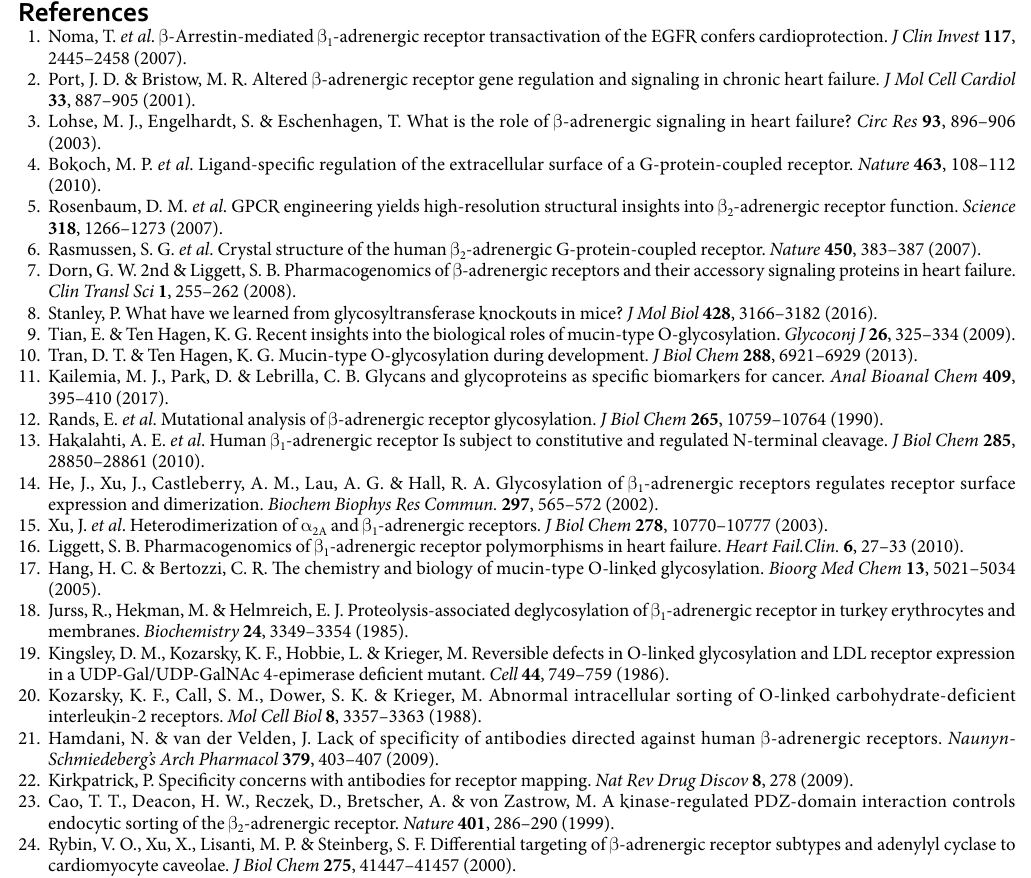
1:1000; anti-pERK at 1:2000 followed by secondary goat anti-rabbit IgG at 1:3000; anti-ERK at 1:3000 followed by secondary goat anti-rabbit IgG at 1:5000; anti- β -actin at 1:2500 followed by secondary goat anti-mouse IgG at 1:4000. Each panel in each figure represents the results from a single gel (exposed for a uniform duration); detec- tion was with enhanced chemiluminescence or LI-COR Odyssey CLx imaging system (LI-COR Biosciences) with image Studio Lite Ver 5.0 software used for quantification of protein expression. All results were replicated in at least three experiments on separate culture preparations. Enzymatic